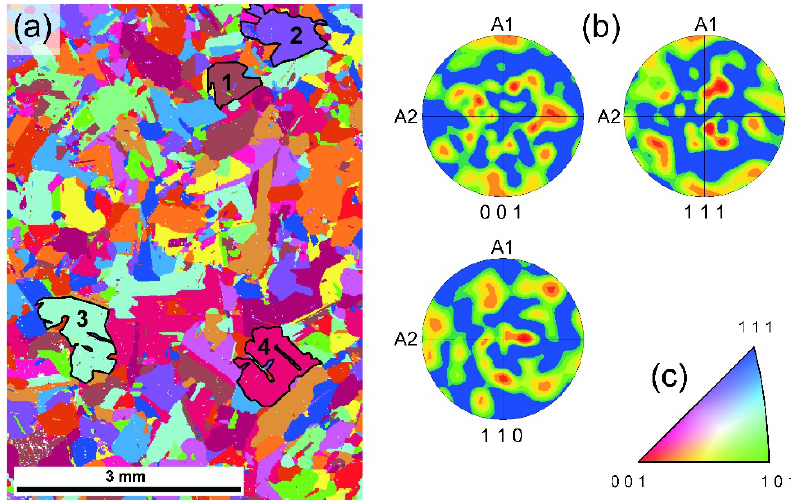
Figure 6. Scanning electron microscopy (SEM) orientation image microscopy: ( a ) Inverse pole figure (IPF) map showing the grain orientation on the rhodium sample; ( b ) pole figure; ( c ) inverse pole figure color coded map.